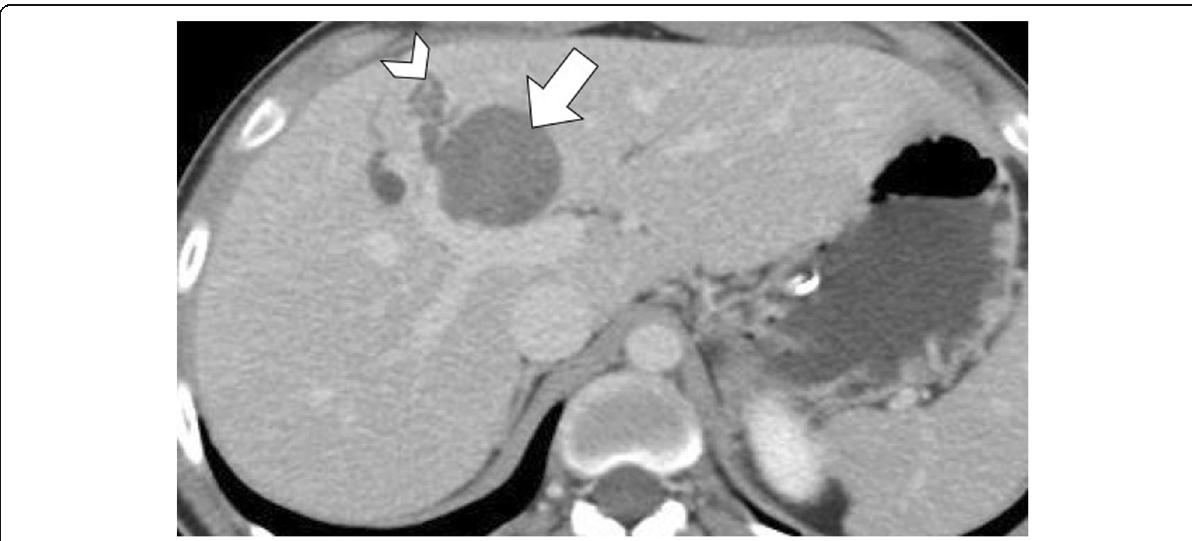
Fig. 15 A 21-year-old man with hepatic hydatid cyst. Axial contrast-enhanced CT image on portal venous phase shows hepatic hydatid cyst (arrow) causing compression and dilatation of adjacent intrahepatic bile ducts